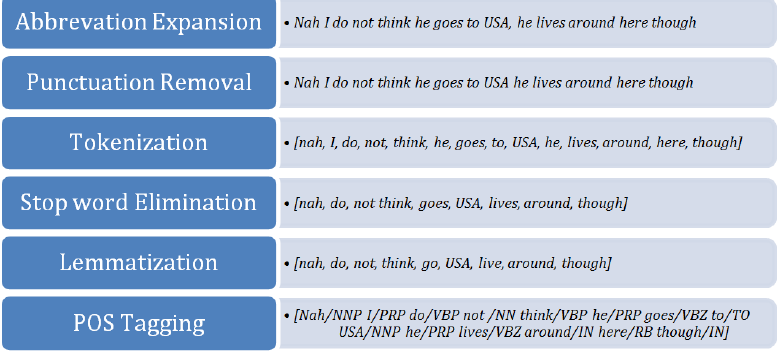
Fig. 2. Steps of stages in